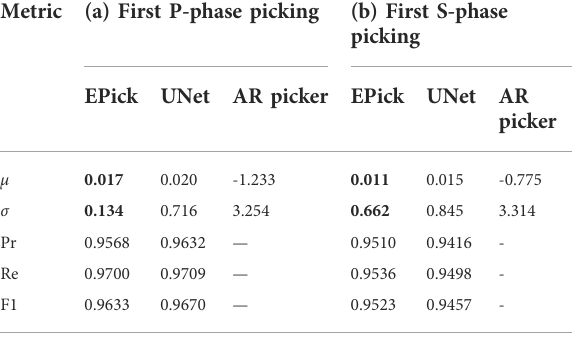
TABLE 1 Earthquake detection performance on the test data of the STEAD dataset (Mousavi et al., 2019). Acc is the overall classi fi cation accuracy. Pr, Re, and F1 are precision, recall, and F1- score respectively. Here, the recursive STA/LTA algorithm is utilized. Metric